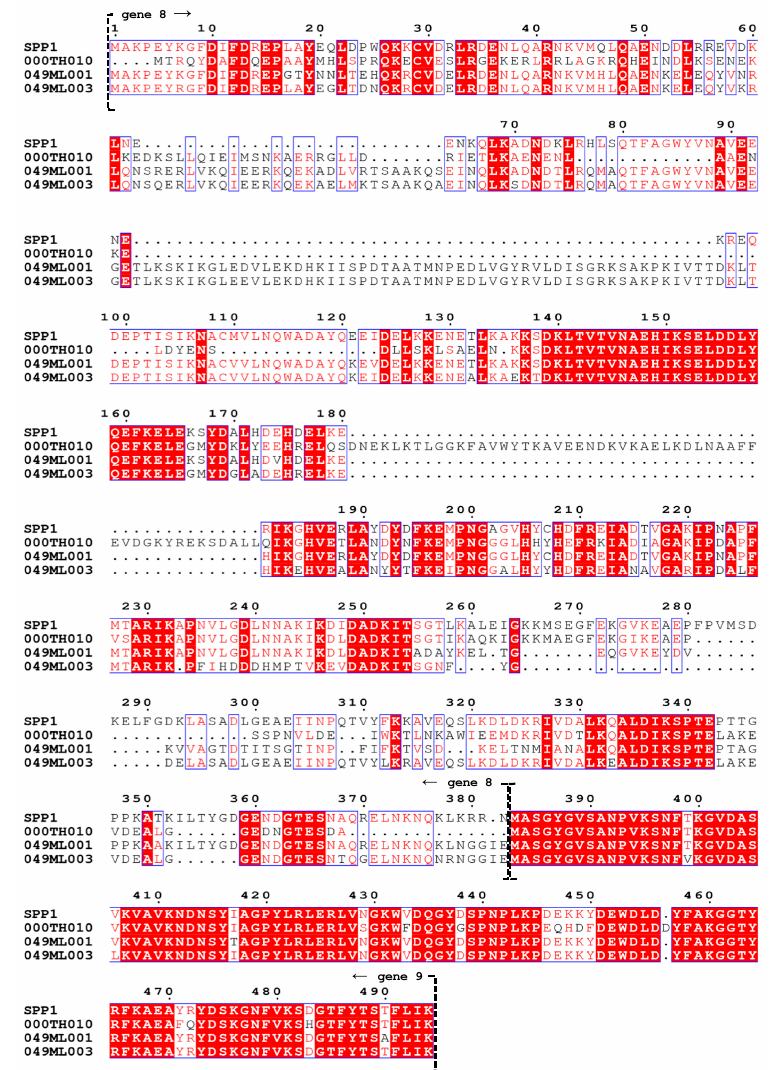
Figure 5. Protein alignment of gene products 8 and 9 in SPP1 and their homologs in our phages. Alignments were constructed using the % Equivalent parameters of ESPript 3.0 [51]. Red lettering indicates sequence and/or physiochemical property matches in the aligned gene products. Black let- tering indicates a mismatch in both sequence and physiochemical property of aligned gene products. Red backgrounds indicate identity across all aligned gene products. Blue boxes indicate consensus in both sequence and physiochemical property across the majority of aligned gene